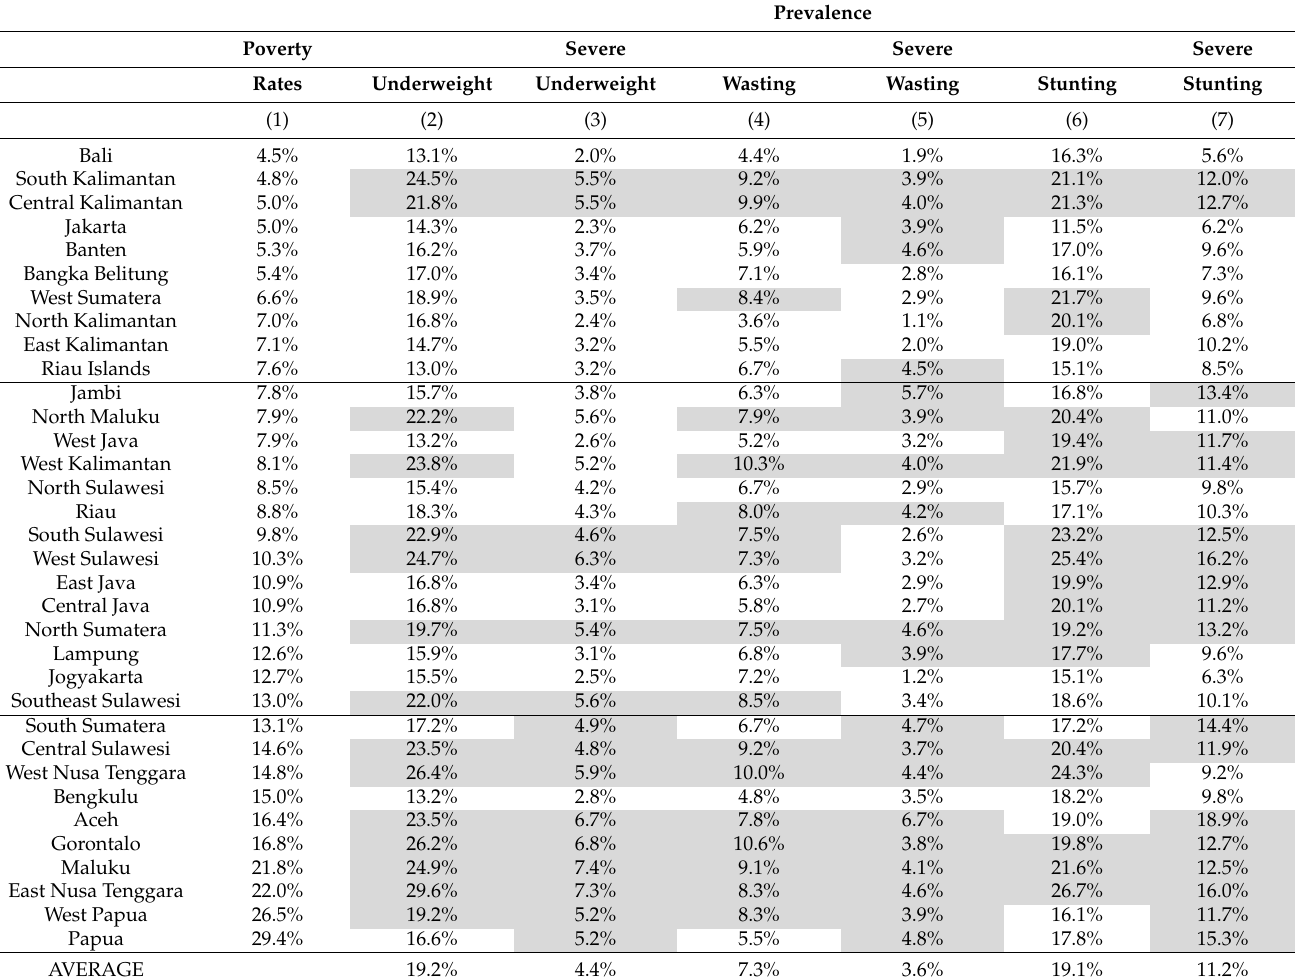
Table 1. Prevalence of child undernutrition by province in Indonesia,